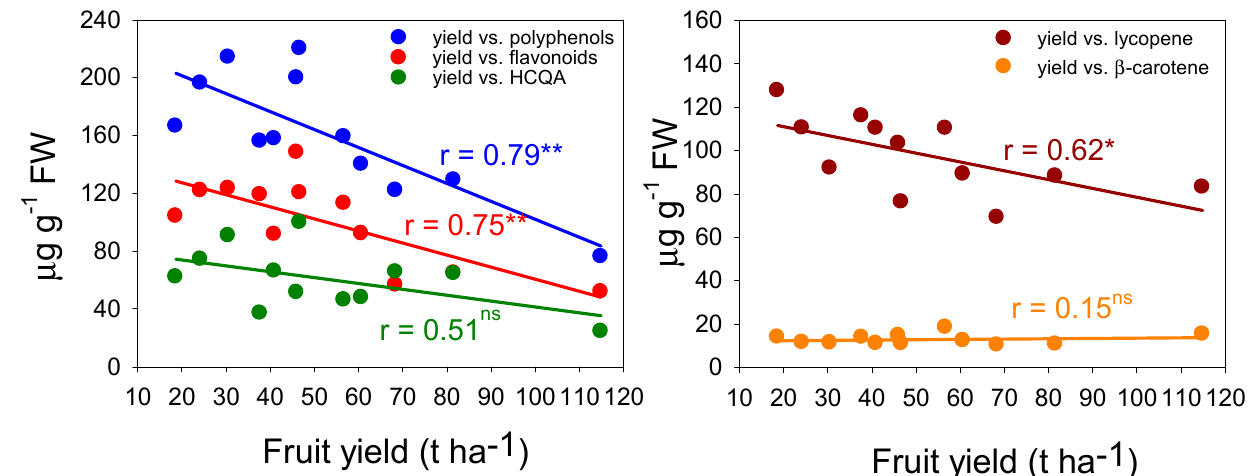
Figure 7. Relationships of fruit yield vs. polyphenols (total, flavonoids, HCQA, on the left ) and carotenoids (lycopene and β -carotene, on the right ) in tomato. Values of correlation coefficient ( r ) and significance (*, **, significant at p ≤ 0.05 and 0.01, respectively; ns, not significant) are reported.